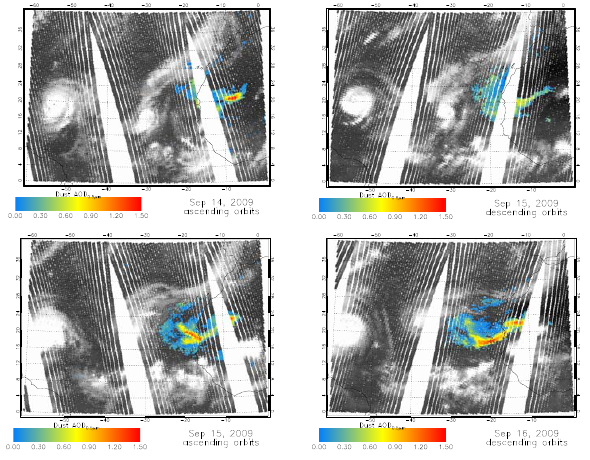
Fig. 7. AVHRR RGB composites (top) and IASI dust effective radius (bottom) for 15 (left) and 16 September (right) descending orbits.